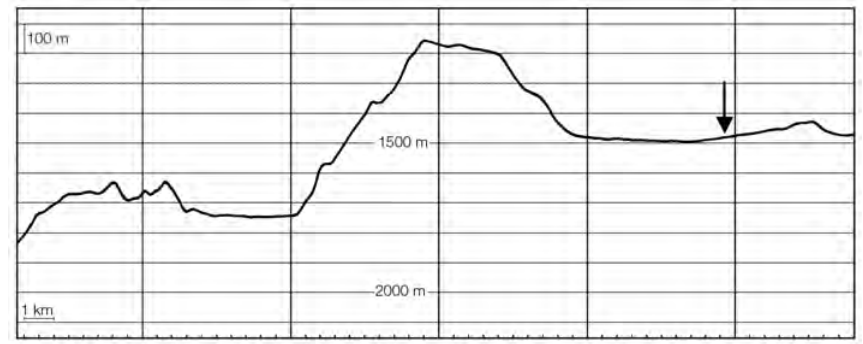
Fig. 5. N-S bathymetric profile parallel to the cable route, based on the data collected to decide the cableway before its deployment. The figure shows, in the middle, a seamount about 10 km wide (N-S direction) and 0.6 km high. The arrow roughly indicates the cable rupture area. The vertical scale is exaggerated 10 times with re- spect to the horizontal